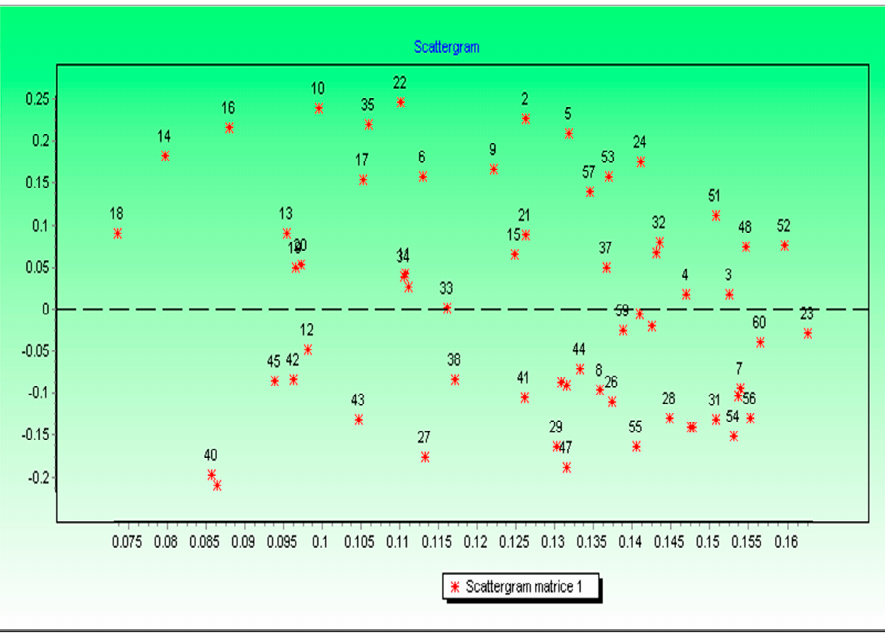
Figure 4. The scattergram matrix environmental variables.